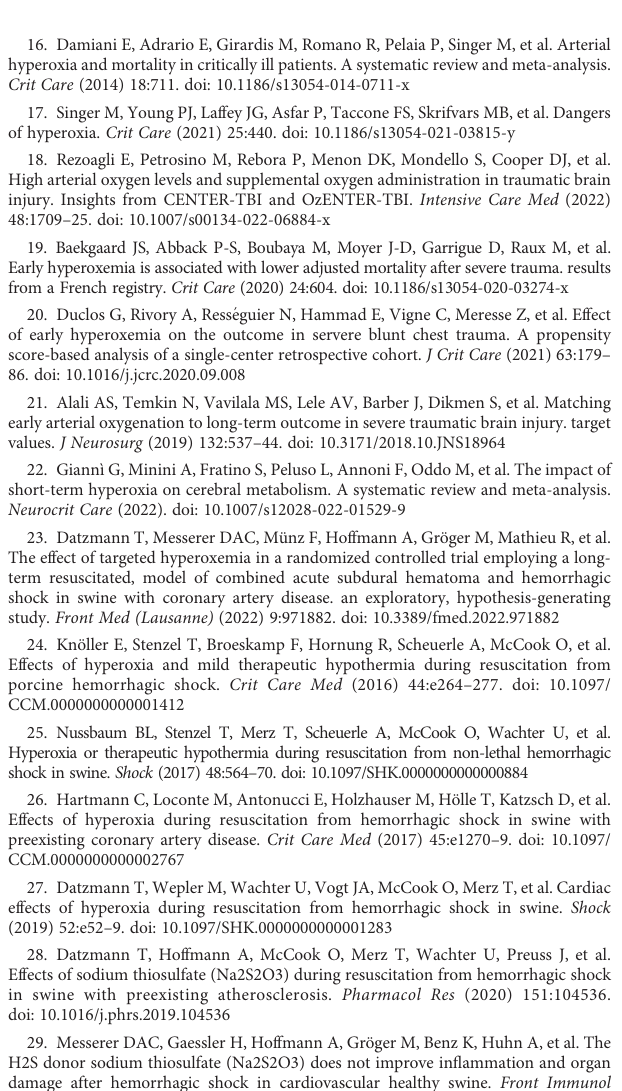
SUPPLEMENTAL FIGURE 1 Results of the metabolic situation at the site of ASDH (ipsilateral) and the opposing hemisphere (contralateral). Measurements were recorded before (pre) and after 2 hrs of hemorrhagic shock and acute subdural hematoma (post)aswellas24hrsand48hrsafterresuscitation.n=3/5beforeshock,5/5 after shock, 4/5 at 24 hrs, and 1/4 at 48 hrs per group for normoxemia (blue, controlgroup,C)andtargetedhyperoxemia(red,H),respectively. (A) Glucose ipsilateral, (B) glucose contralateral, (C) glutamate ipsilateral, (D) glutamate contralateral, (E) pyruvate ipsilateral, (F) pyruvate contralateral, (G) lactate ipsilateral, and (H) lactate contralateral. Mann-Whitney U test. Box plots report median, interquartile range, minimum, and